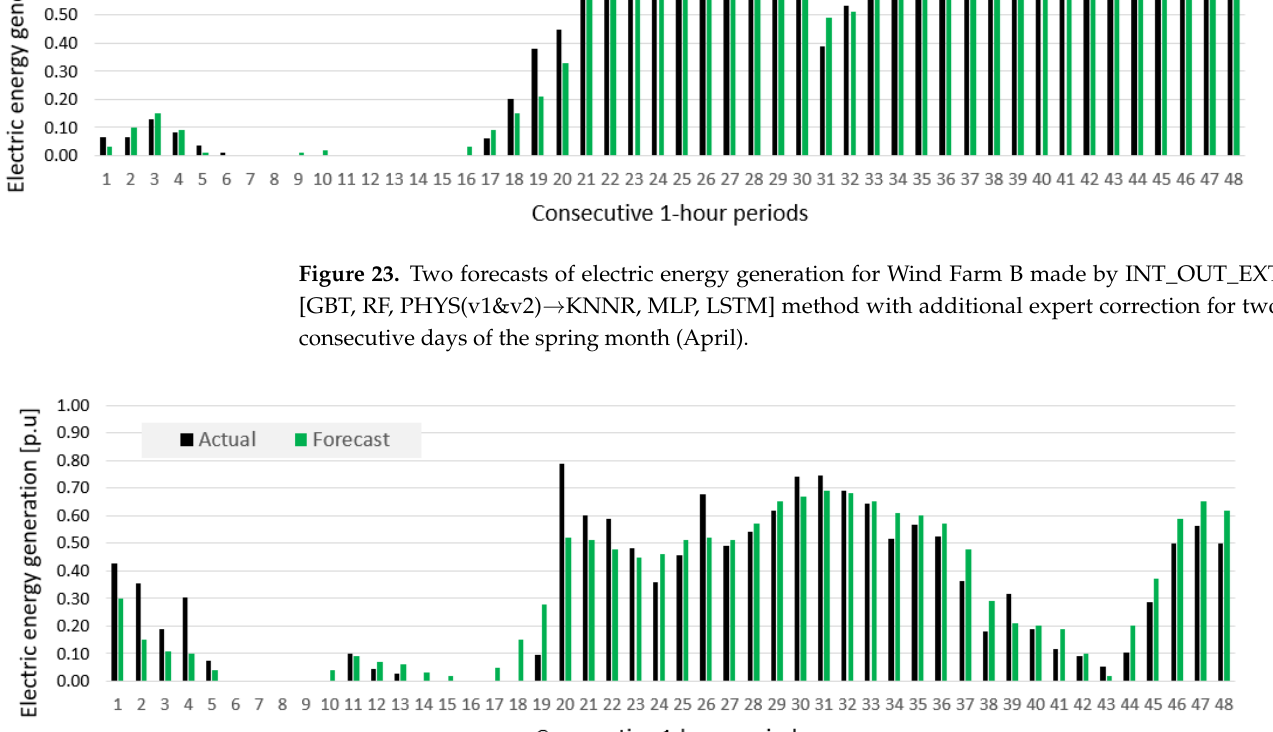
Figure 24. Two forecasts of electric energy generation for Wind Farm B made by INT_OUT_EXT [GBT, RF, PHYS(v1&v2) → KNNR, MLP, LSTM] method with additional expert correction for two consecutive days of the summer month (August).